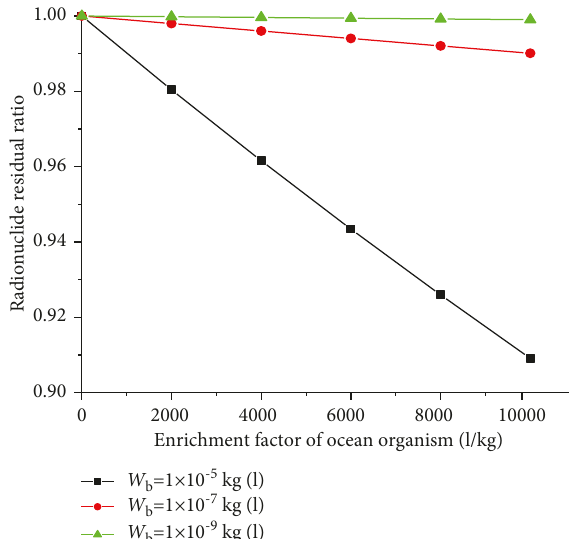
Figure 8: The radionuclide residual ratio change with the en- richment factor of ocean organism.